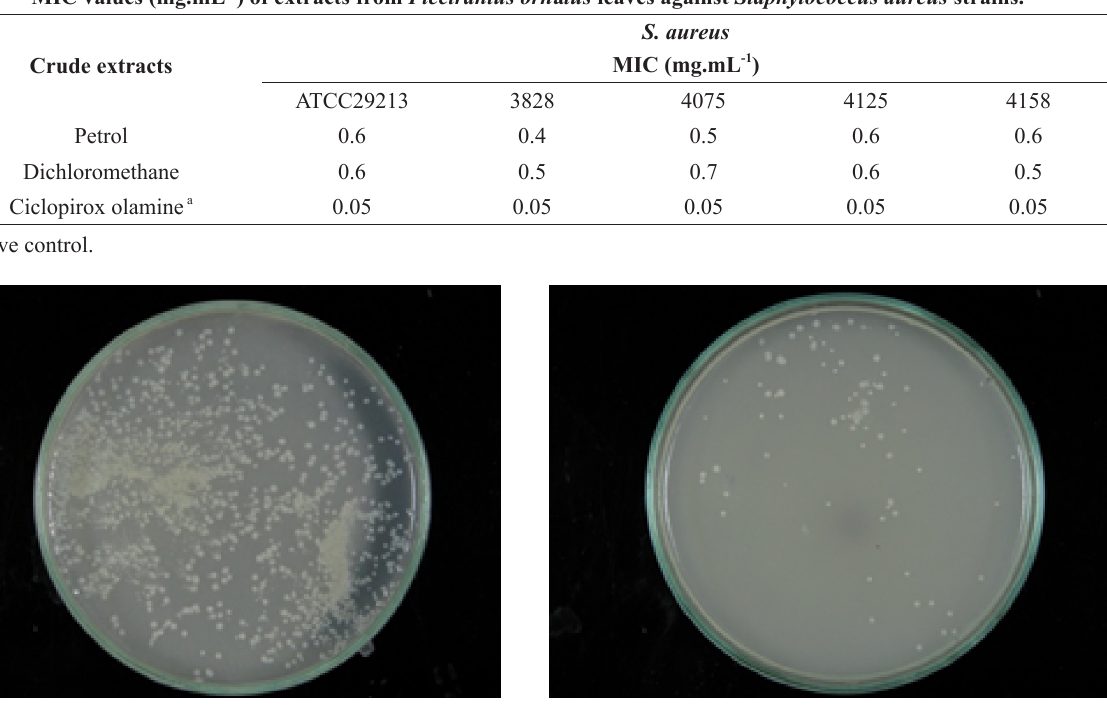
Figure 1 - In vitro antibacterial activities of herbal soap produced with the active extract of P. ornathus. Tests were performed in triplicate.